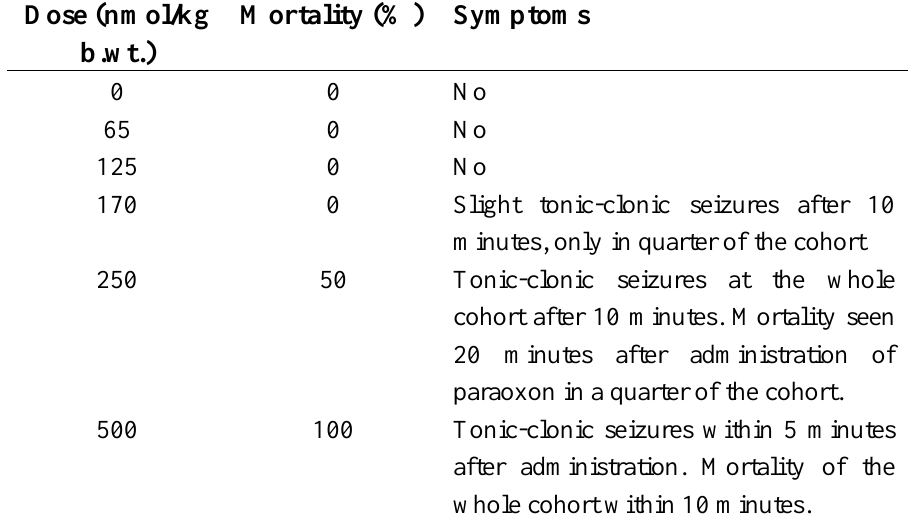
Table 1. Mortality progression as the increased dose of paraoxon administered into